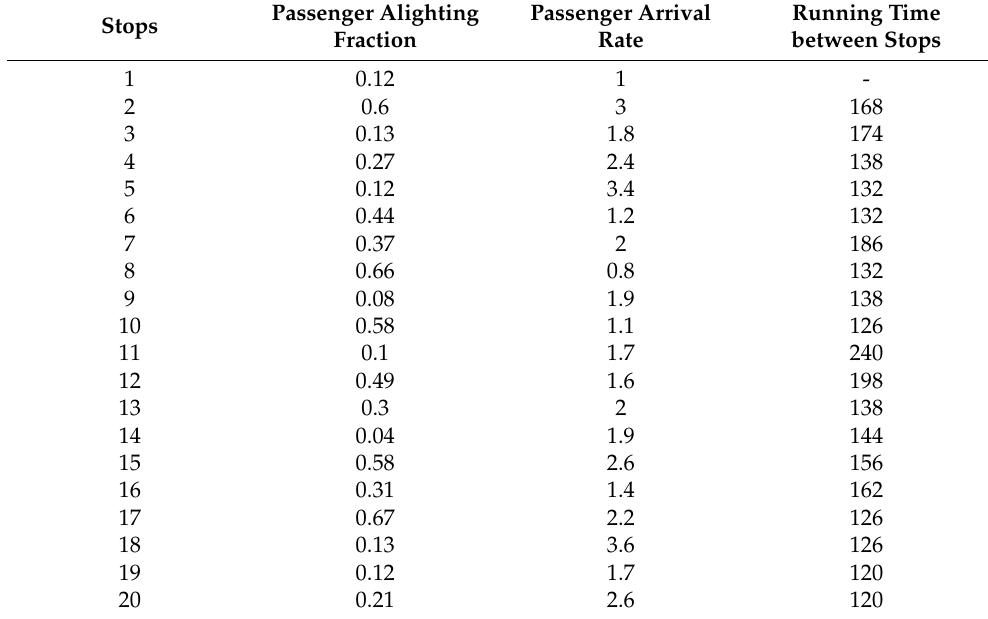
Table A4. Values of stochastic parameters in scenario